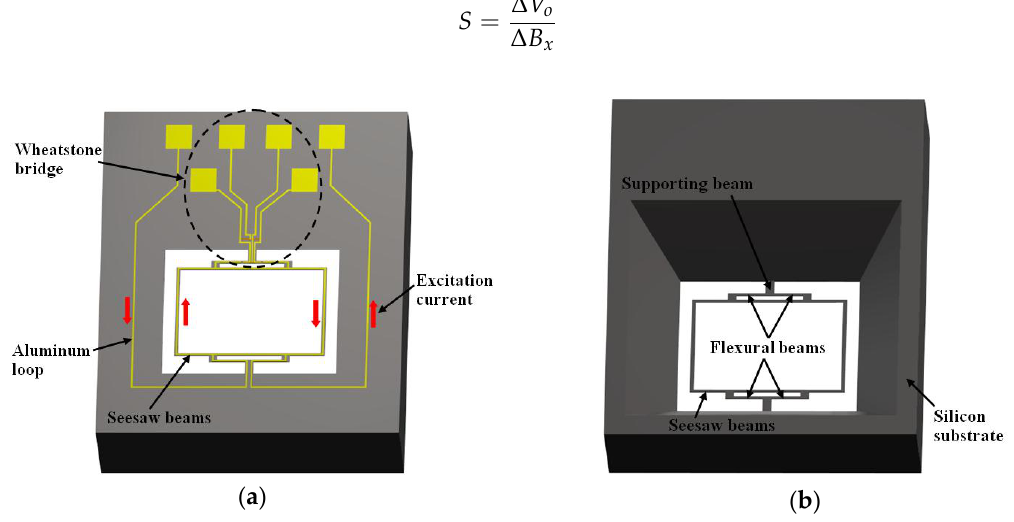
Figure 5. 3D schematic view of the ( a ) upper and ( b ) bottom design of magnetic field sensor, which contains a silicon resonator, an aluminum loop and a Wheatstone bridge [21]. Reprinted with permission from [21]. Copyright© 2011, Elsevier B.V.